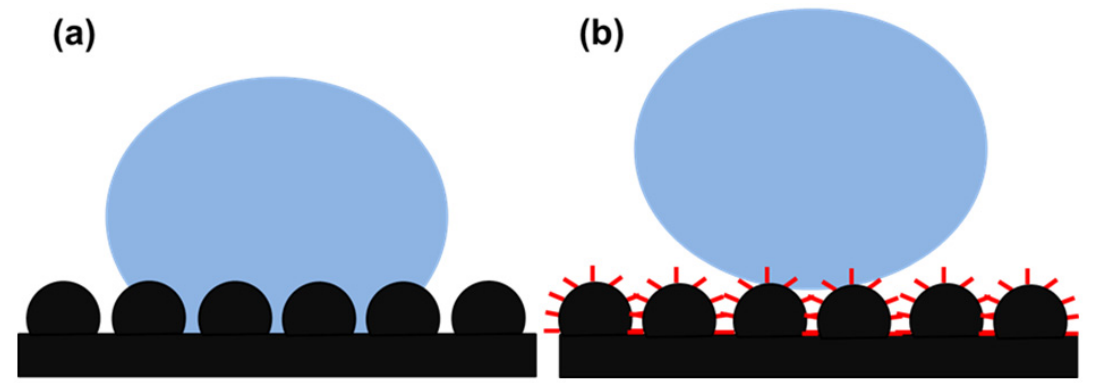
Figure 2. A schematic showing the behavior a water droplet on a rough surface in ( a ) Wenzel’s and ( b ) Cassie-Baxter’s